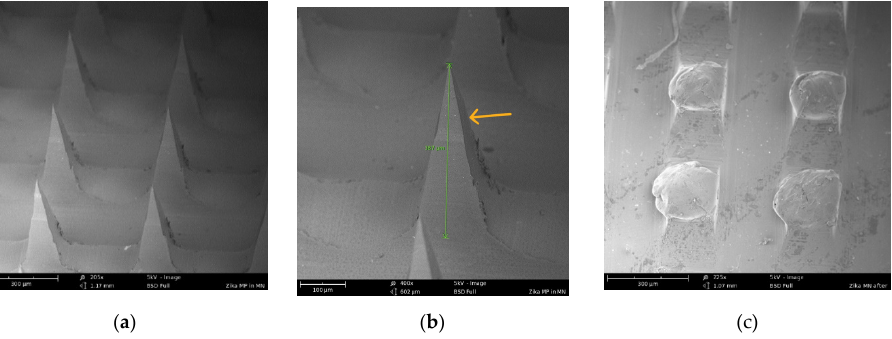
Figure 2. ( a ) SEM image (205×) of pyramid-shaped MNs in the array before application to murine skin. ( b ) SEM image (400×) showing the length (387 um) of one pyramid-shaped microneedle in the array. ( c ) SEM image (225×) of dissolved microneedles in the array after application to murine skin for 10 min.